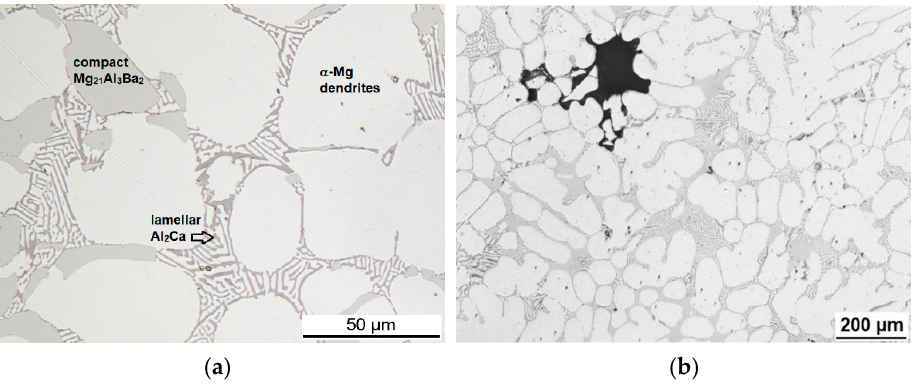
Figure 1. Micrographs of DieMag633 presenting interdendritic network of second phases Mg 21 Al 3 Ba 2 and Al 2 Ca ( a ) and porosity and shrinkage cavities in black color ( b ). and Al 2 Ca ( a ) and porosity and shrinkage cavities in black color ( b